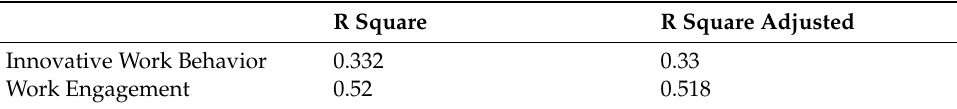
Table 7. R-square.